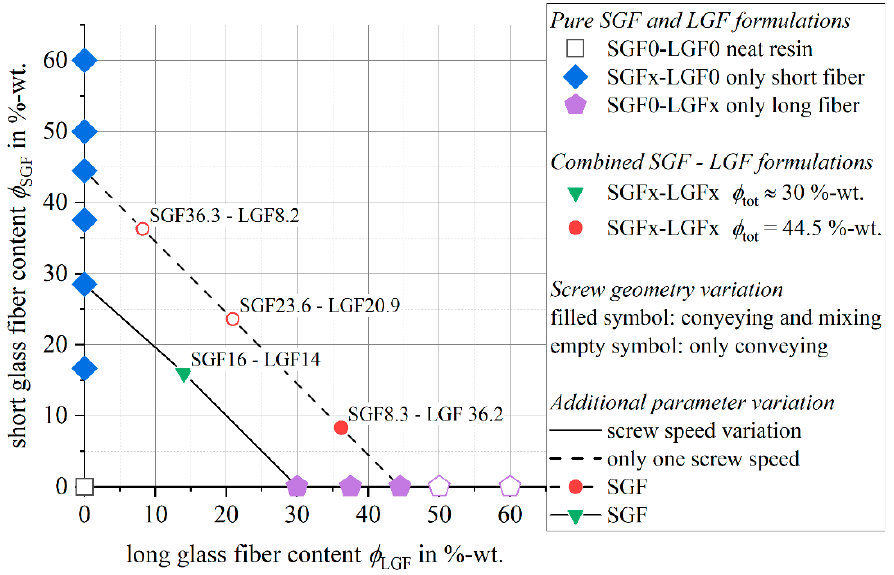
Figure 1. Material and process variations.